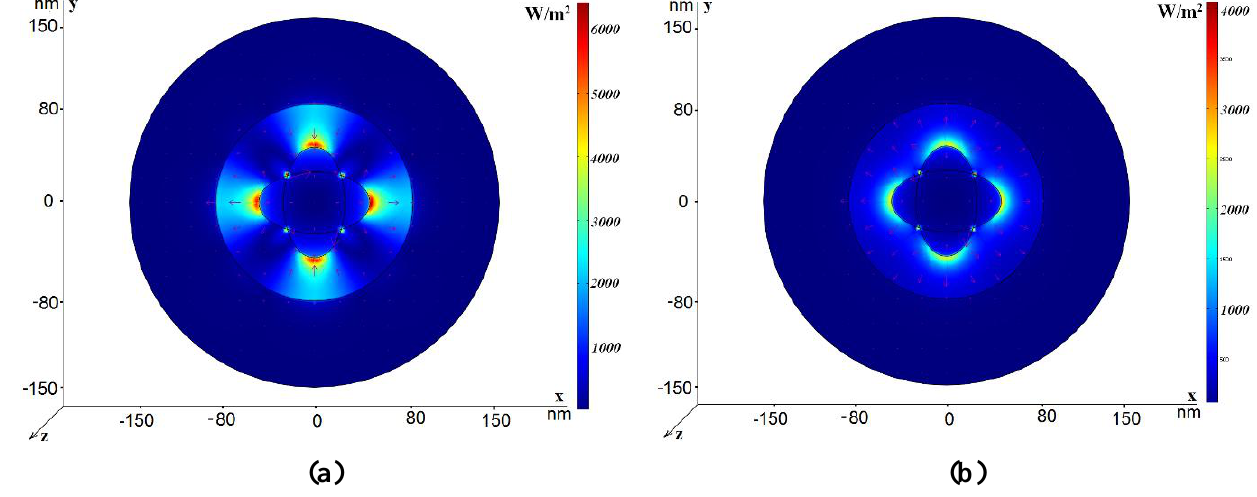
Figure 7. Power flow distribution for two modes in the case R large ellipse semi-axis is 45 nm and the small ellipse semi-axis is 25 nm. The electric field vector is shown by arrows. ( a ) The quadrupole-like mode, n TEM-like mode, n = 3.022 + i eff